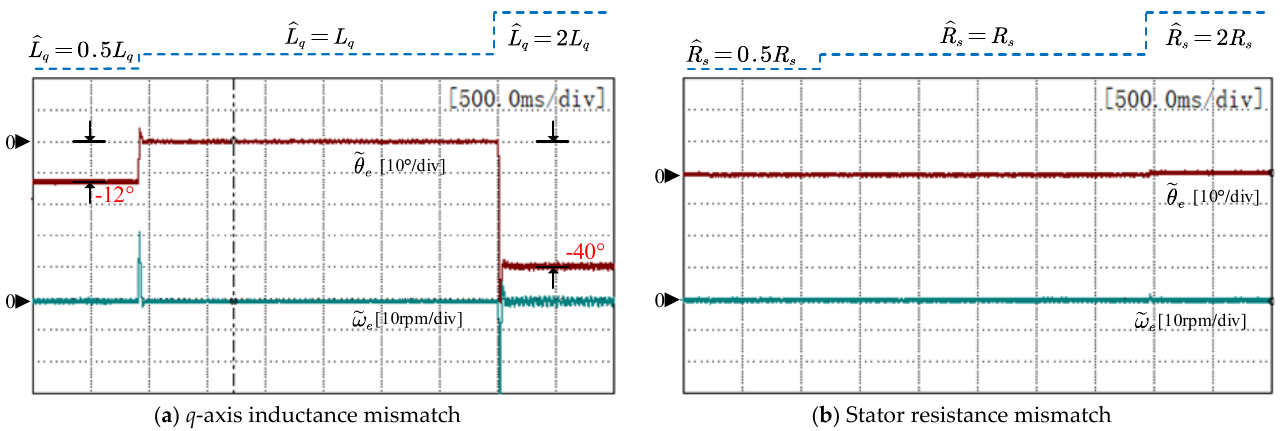
Figure 19. Experimental results of the position estimation error and the speed estimation error at 1500 rpm with mismatched parameters (enhanced LESO-based QPLL).